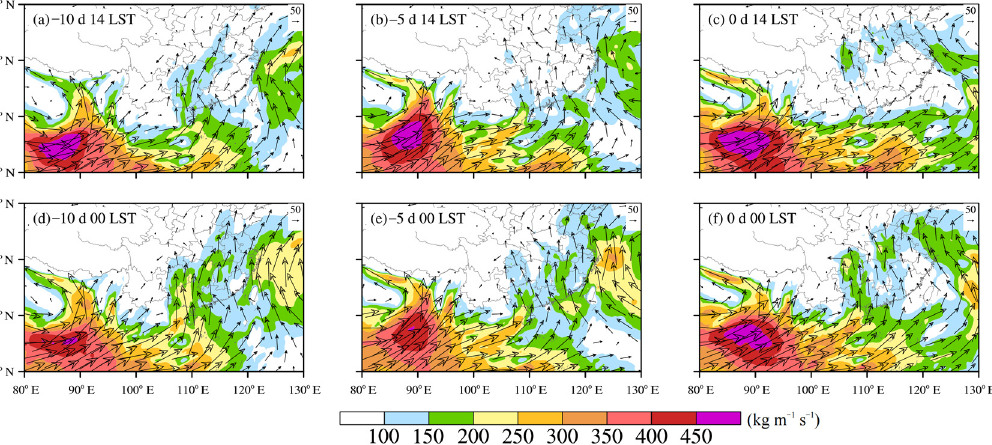
Figure 5. Spatial distribution of moisture flux from surface to 700hPa on the ( a , d ) 10th day ( − 10 d), ( b , e ) 5th day ( − 5 d) before the rainstorm occurs, and ( c , f ) the day (0 d) when the rainstorm occurs.